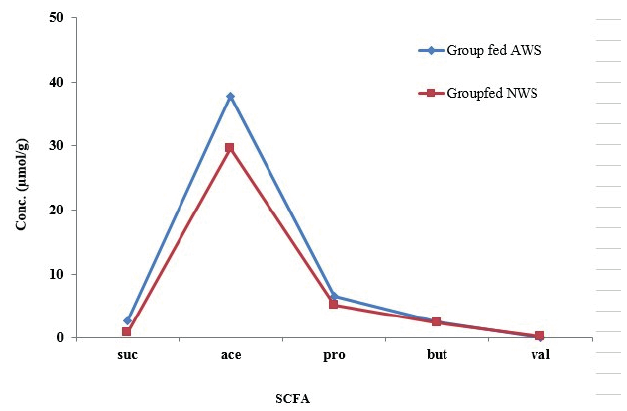
FIGURE 4 - The content of SCFAs in the caeca of mice in two group NWS and